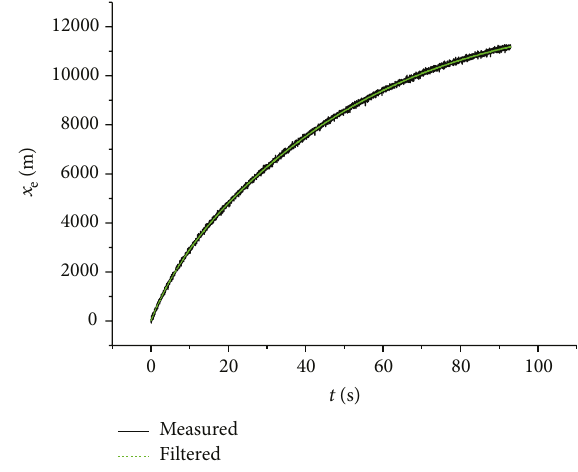
Figure 8: Coordinate x